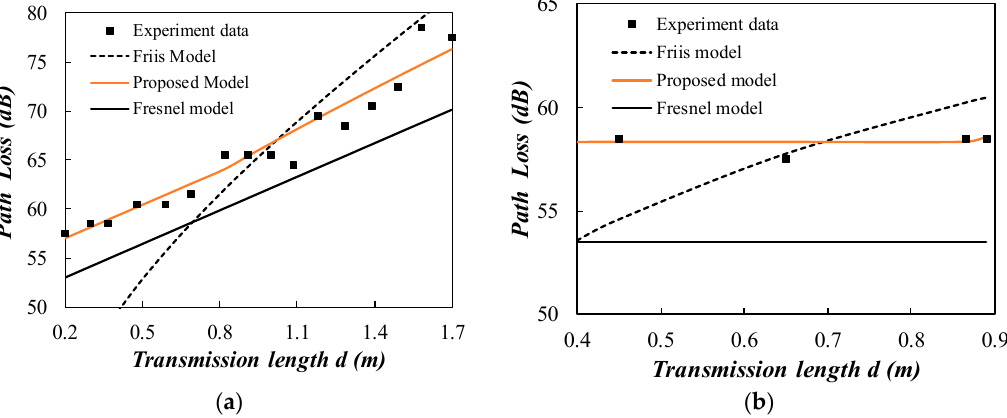
Figure 8 . Comparison of the measured path loss with the propagation models (sand). ( a ) wet sand; ( b ) dry sand.